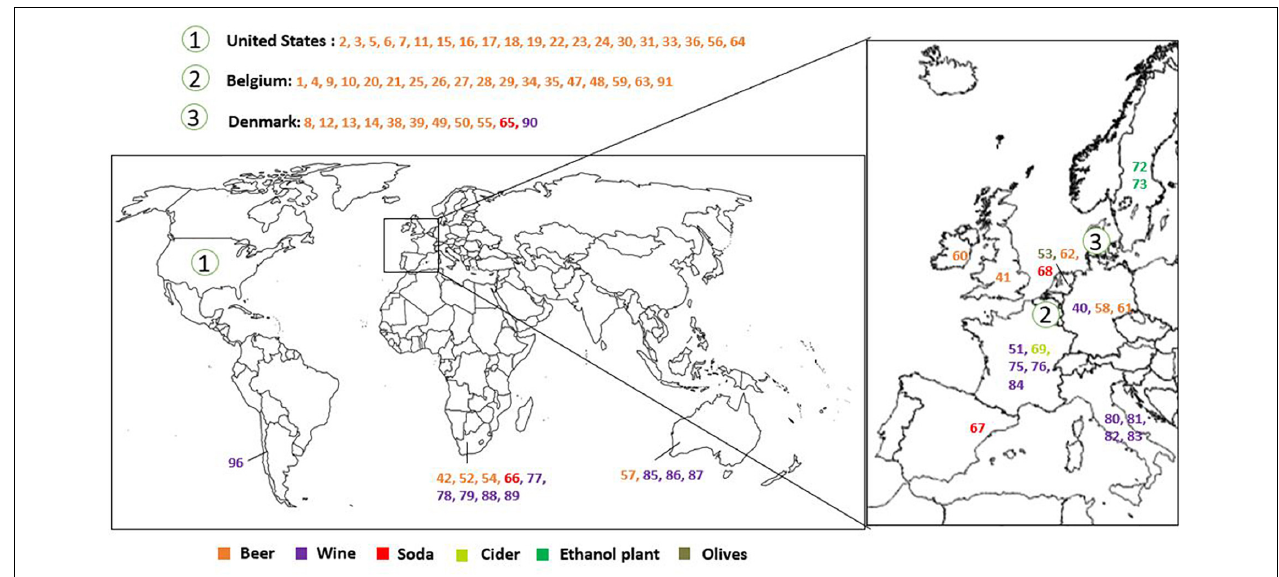
FIGURE 1 | Geographical distribution and substrate of origin of the Brettanomyces strains included in the